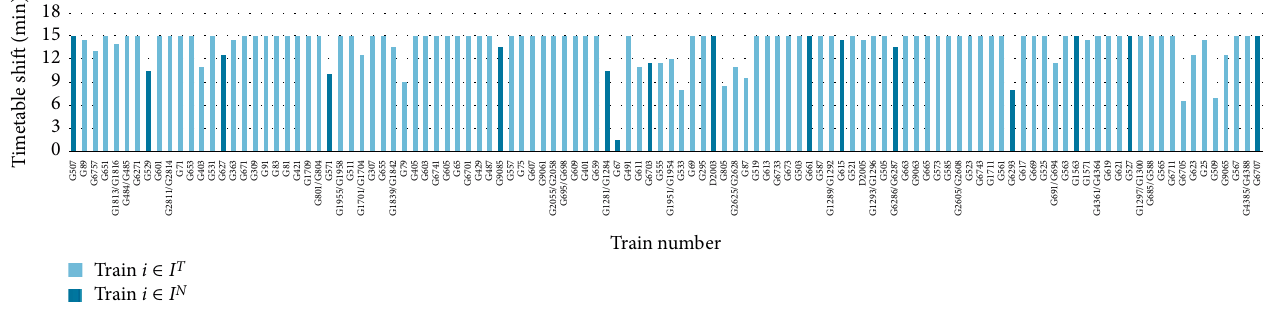
Figure 6: Effects of departure and arrival timetable windows on synchronization.